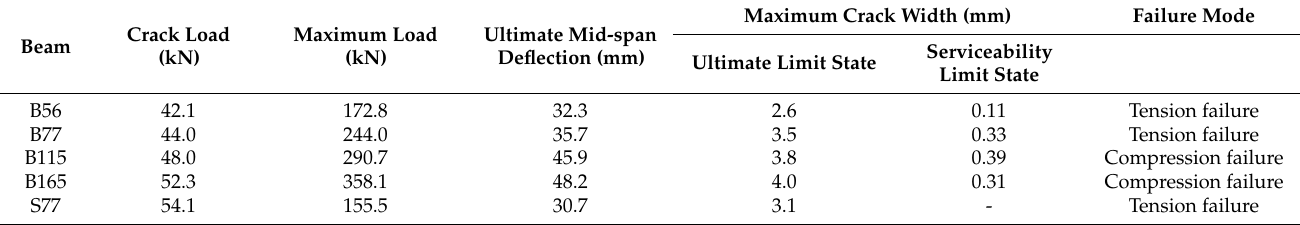
Table 4. Summary of flexural test results.